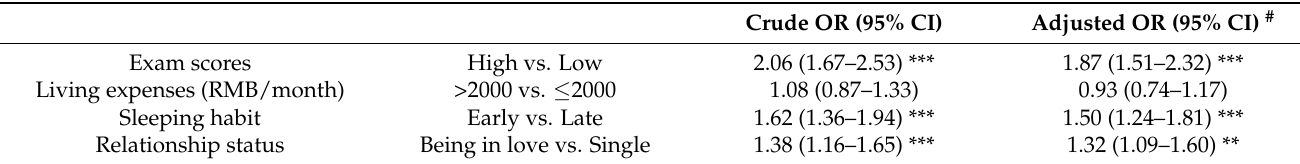
Table 4. Odds ratio (95%CI) of college student happiness for social factors ( n =